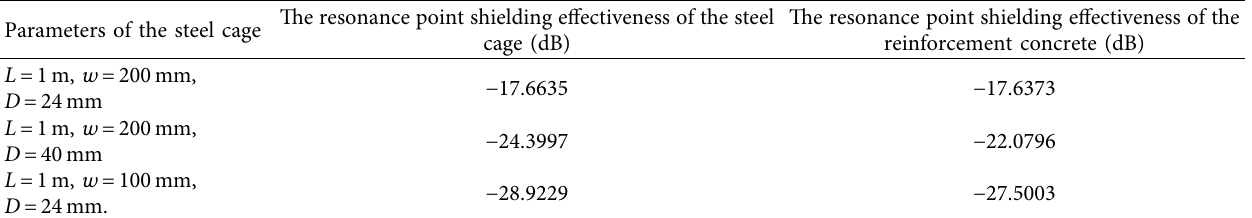
Table 1: Comparison of the resonance point shielding efectiveness under diferent steel structure parameters. Te resonance point shielding efectiveness of the steel Te resonance point shielding efectiveness of the Parameters of the steel cage cage (dB)